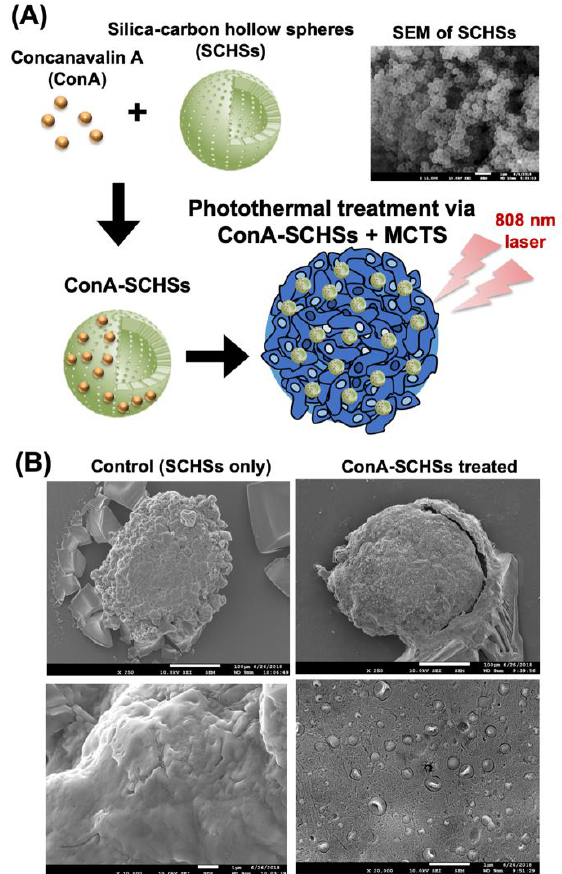
Figure 5. Illustration and SEM images of ConA-SCHSs (concanavalin A-silica–carbon hollow spheres) conjugation for the photothermal treatment of the MCAs. ( A ) ConA bound to uniformly sized SCHSs (shown in SEM) was applied to the MCAs and irradiated by an 808 nm laser for the photothermal treatment. ( B ) The SEM images of the MCAs treated with SCHSs or ConA-SCHSs.